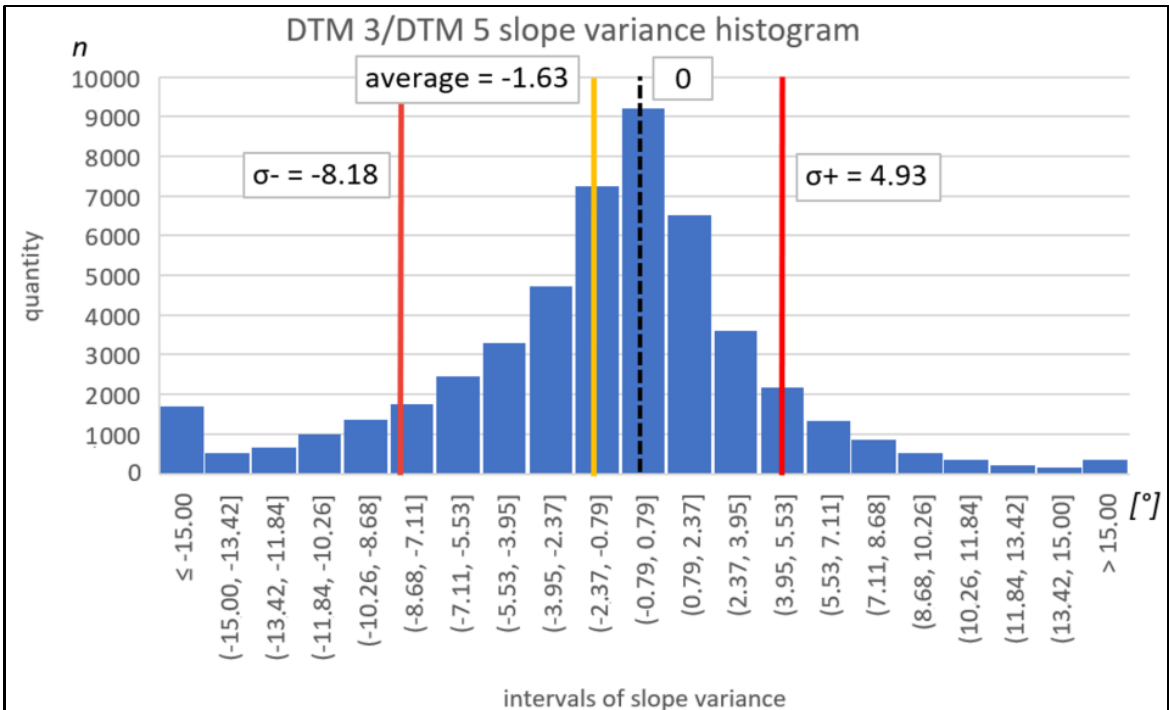
Figure 3. Histogram of standard deviations of the comparison between DTM 3 and DTM 5 for slopes at 50,000 points.